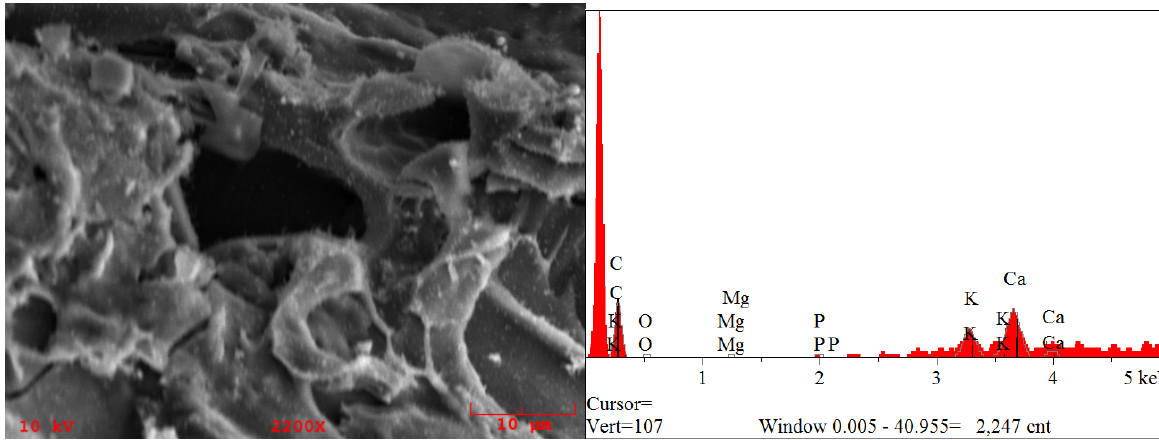
Figure 13. Surface area analysis from inner wood biochar (minerals from left to right C, K, O, Mg, P, K, Ca).